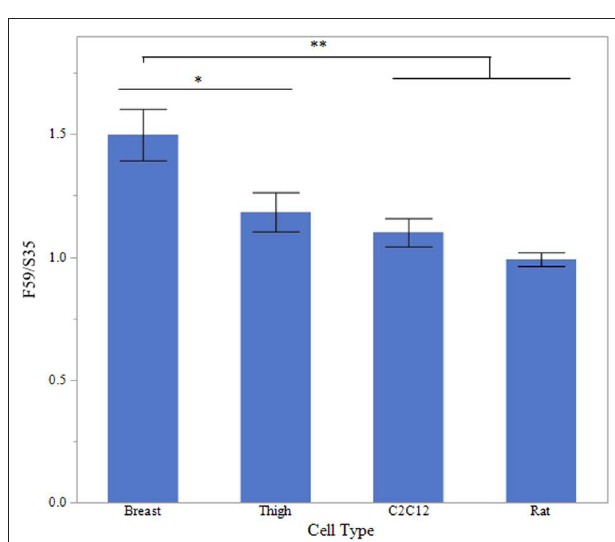
FIGURE 7 | Fast to Slow ratio between cell types. Western blot densitometry of sodium acetate (10mM) treated myotubes from primary breast, primary thigh, C2C12, and primary rat cultures for fast (F59) and slow (S35) myosin heavy chain isoforms ( n = 6). Relative MHC expression is presented as a ratio of fast to slow MHC isoform expression. Asterisk represent significant differences between treatments for each cell type (* P < 0.05; ** P <